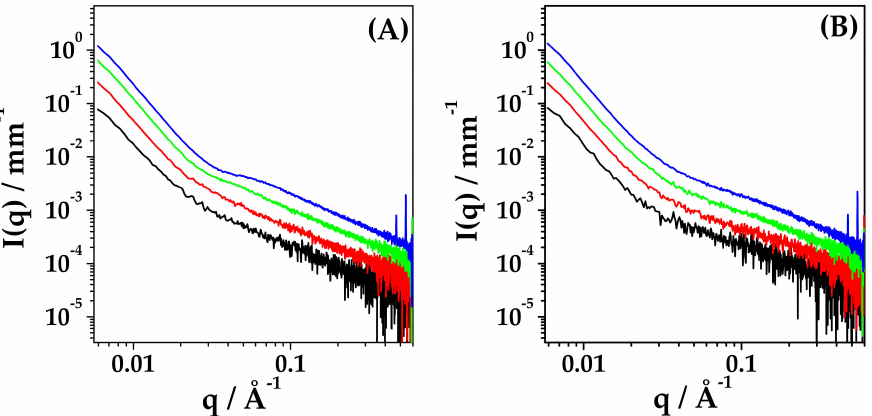
Figure 7. SAXS spectra of HYA–DEX nanoparticles 0.55:0.45 weight fraction at different concentra- tions in salt-free water ( A ) and in PB ( B ). HYA–DEX concentration: 2.5 mg/mL (black), 5 mg/mL (red), 10 mg/mL (green) and 20 mg/mL